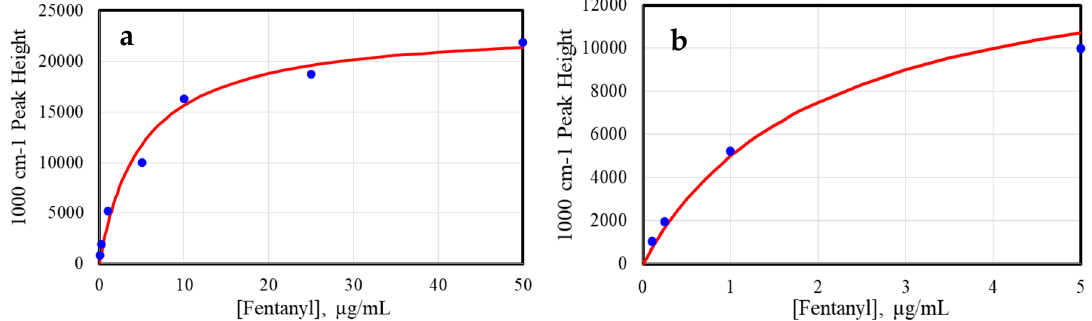
Figure 5. Plot of fentanyl 1000 cm − 1 peak height as a function of the concentration, fit with a Langmuir curve for ( a ) 100 ng/mL to 50 µg/mL, and ( b ) 100 ng/mL to 5 µg/mL.